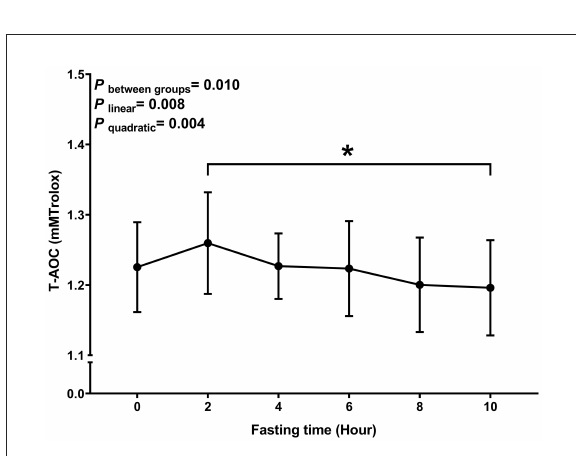
FIGURE3 Postprandial changes in plasma T-AOC. Data are presented as the means, with the error bars representing the 95% confidence intervals of the means. *Indicates a statistically significant difference of T-AOC at the 10th hour as compared with the other time points at alpha = 0.05; all statistically significant differences are displayed.